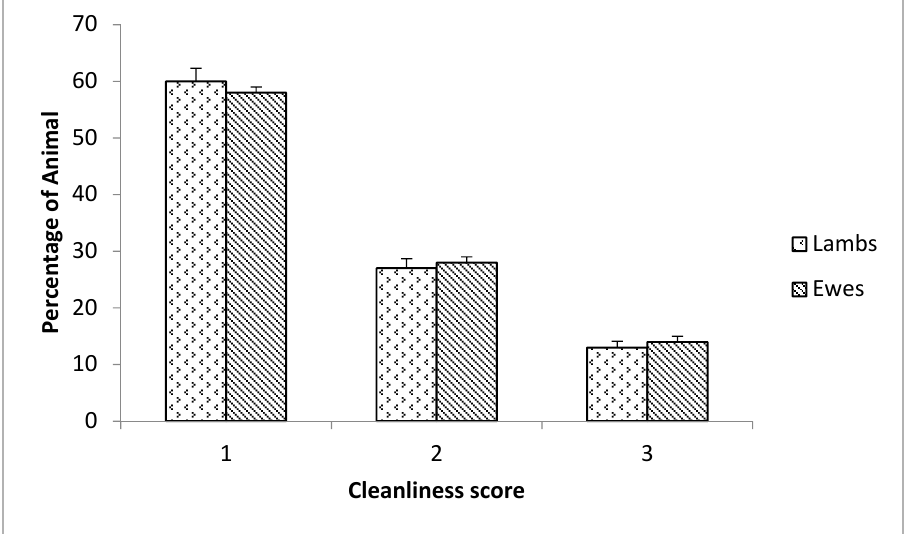
Figure 1. Distribution of the average scores of body condition for the studied sheeps at lambing, mid-lactation, and weaning.